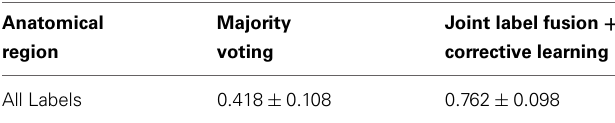
Table 3 | Segmentation performance in Dice Similarity Coefficient (cid:2) (cid:3) 2 | A ∩ B | produce for the canine leg muscle testing | A |+| B |